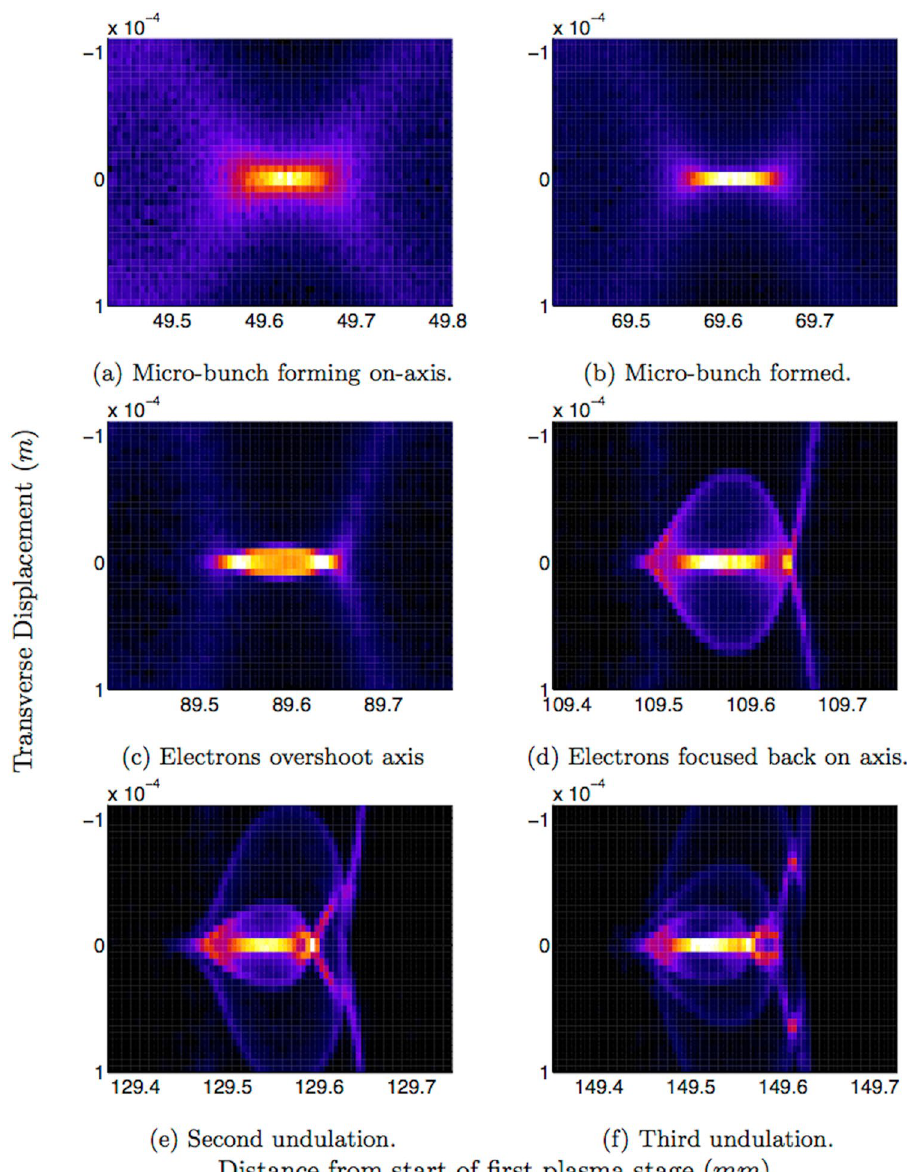
Figure 3. Coherent undulations of the simplified Diamond beam in the second plasma stage. Electron number density of the beam electrons is seen form a top down view. The focusing fields of the wakefield bring the micro- bunch electrons on-axis ( a ). The micro-bunch has maximum on-axis number density in ( b ) and is regarded as formed. The electrons overshoot the axis in ( c ). The bulk of the electrons are focused back on axis whilst some escape the focusing field in ( d ). A second and third undulation is seen in ( e , f